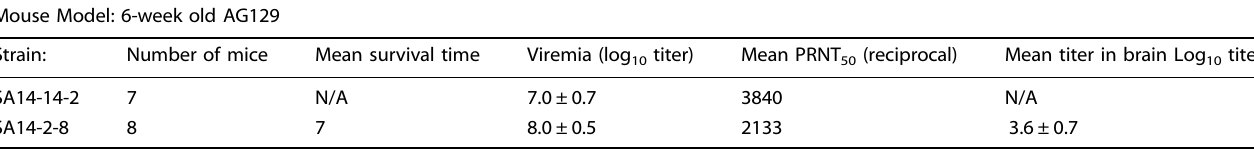
Table 3. Outcome of subcutaneous inoculation of A129 mice with JEV vaccine strains. Mouse Model: 6-week old AG129